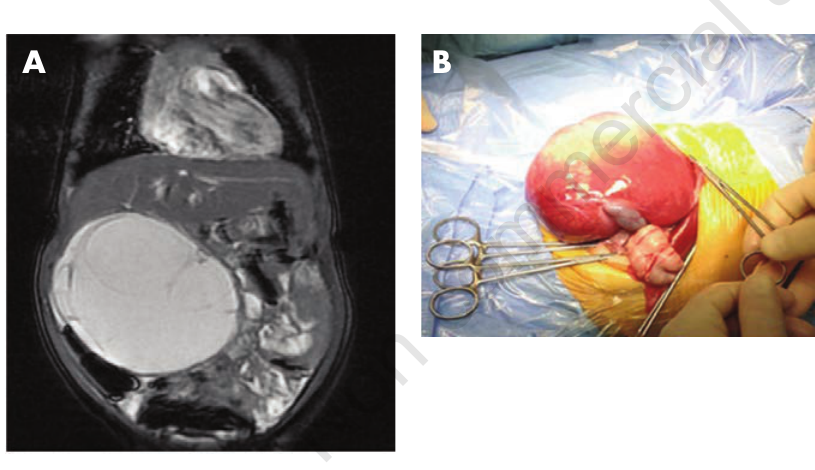
Figure 2. A) Magnetic resonance imaging coronal view of the multiloculated cystic mass in the right upper abdomen (benign hepatic mesenchymal cystic liver hamartoma). B) Intraoperative findings.